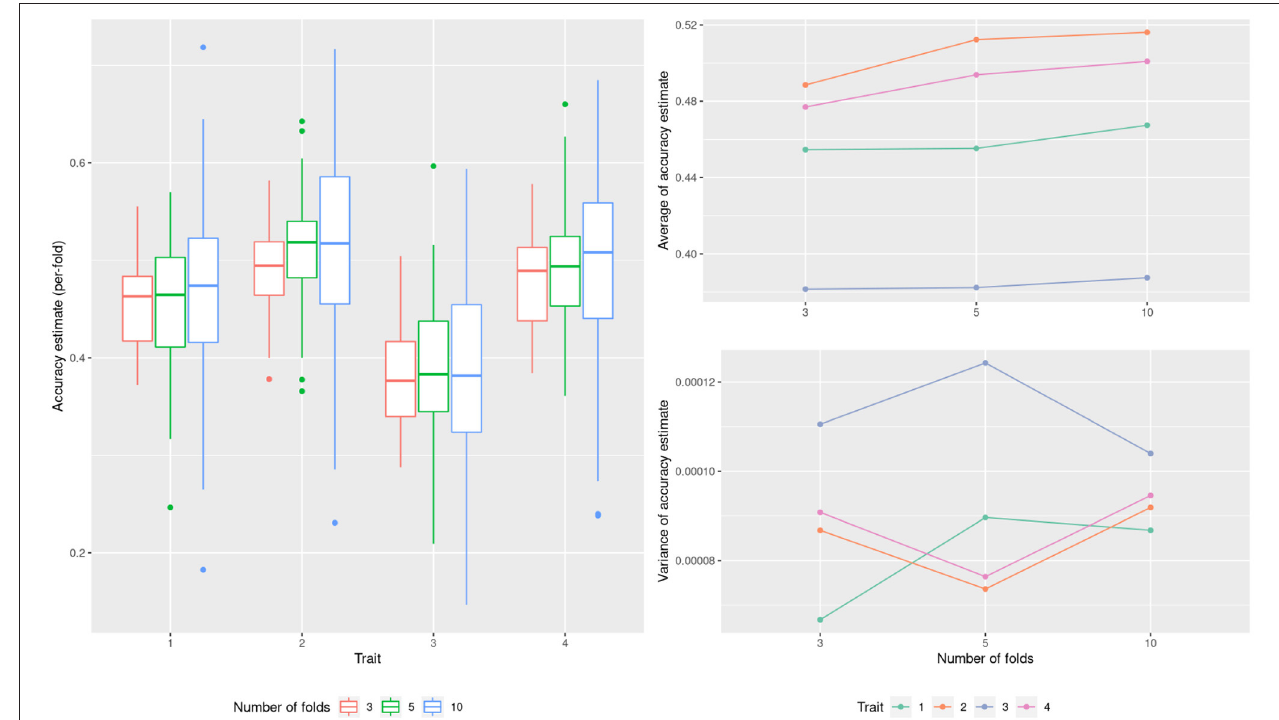
FIGURE 2 | Model performance estimation for the wheat dataset with varying number of cross-validation folds.